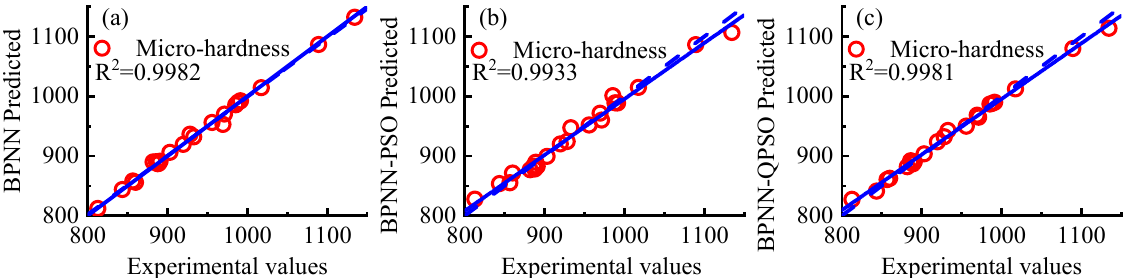
Figure 10. Scatter plot of training values and experimental values of micro-hardness: ( a ) BPNN; ( b ) BPNN-PSO; ( c ) BPNN-QPSO.